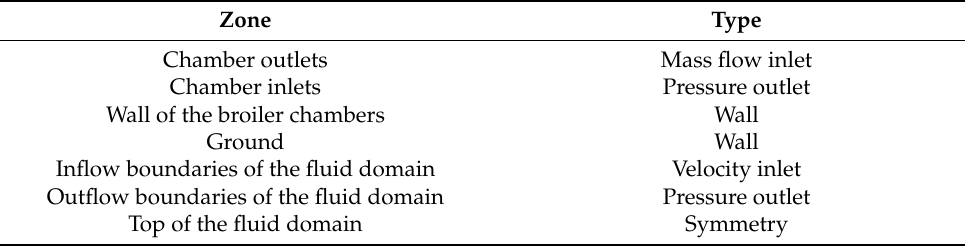
Table 2. Boundary conditions of each